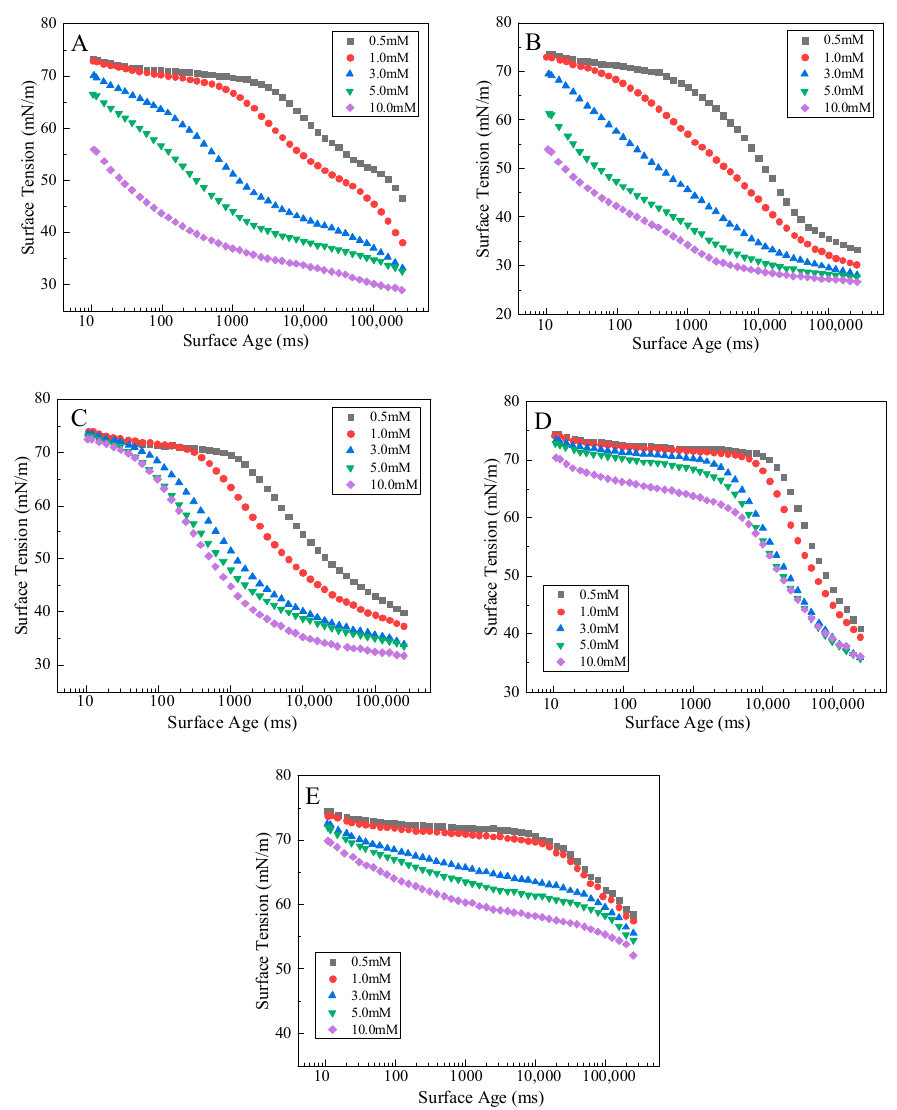
Figure 3. Relationship between the dynamic surface tension of ( A ) C 8 DDGPB, ( B ) C 10 DDGPB, ( C ) C 12 DDGPB, ( D ) C 14 DDGPB, and ( E ) C 16 DDGPB surfactant aqueous solutions and time.